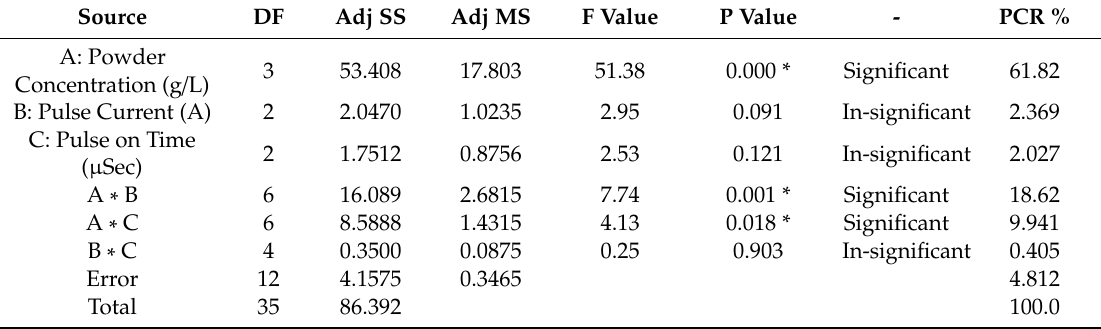
Table 6. Analysis of variance of surface roughness.